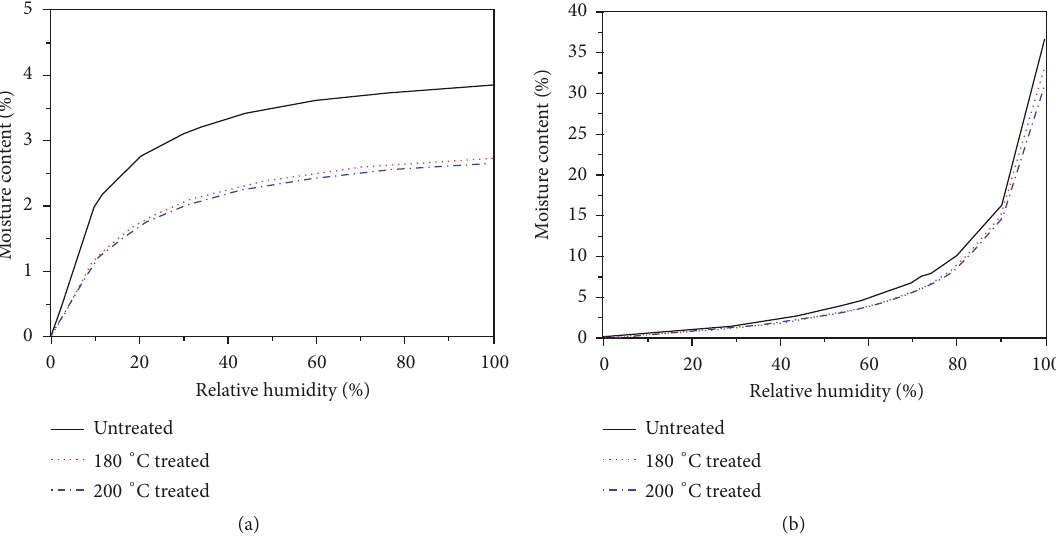
Figure 3: Moisture content of samples for (a) hydrated water and (b) dissolved water.